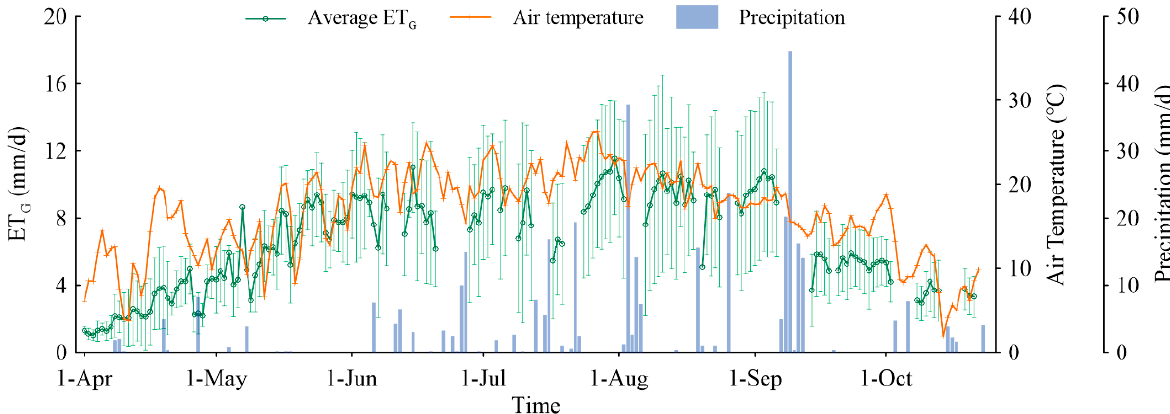
Figure 7. Average groundwater evapotranspiration (ET G ) and the standard deviation of ET G at all the observation wells with air temperature and precipitation over the growing season.